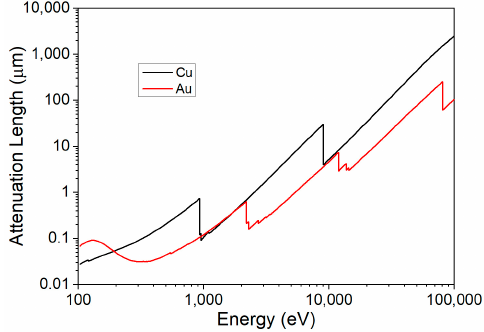
Figure 12. X-ray attenuation length as a function of the energy of the photons for copper and gold.